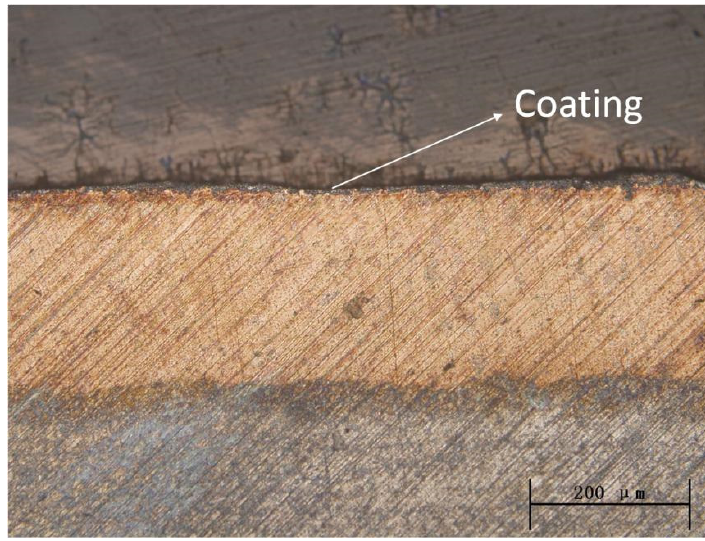
Figure 6. Section view of bearing bush.